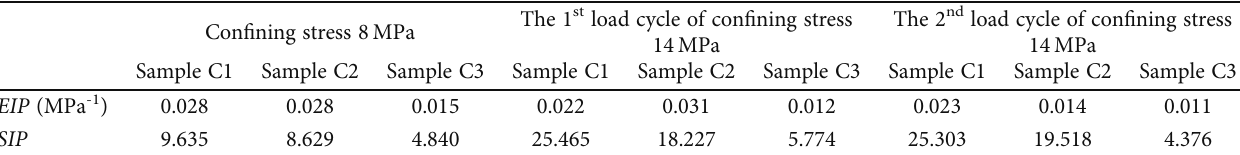
Table 4: The EIP and SIP calculated results under cyclic deviatoric